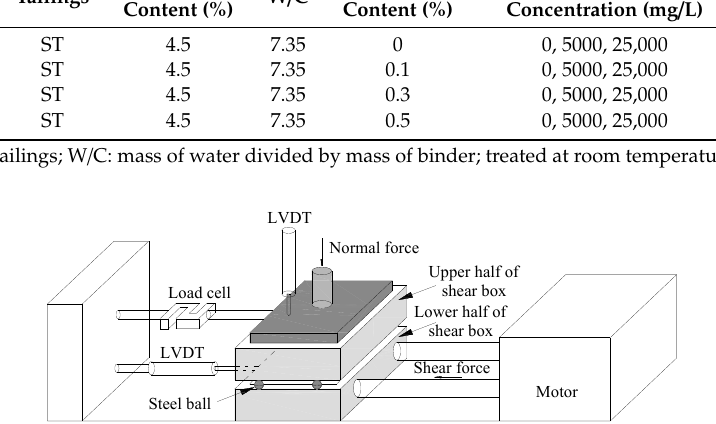
Figure 4. Schematic diagram of the direct shear device.